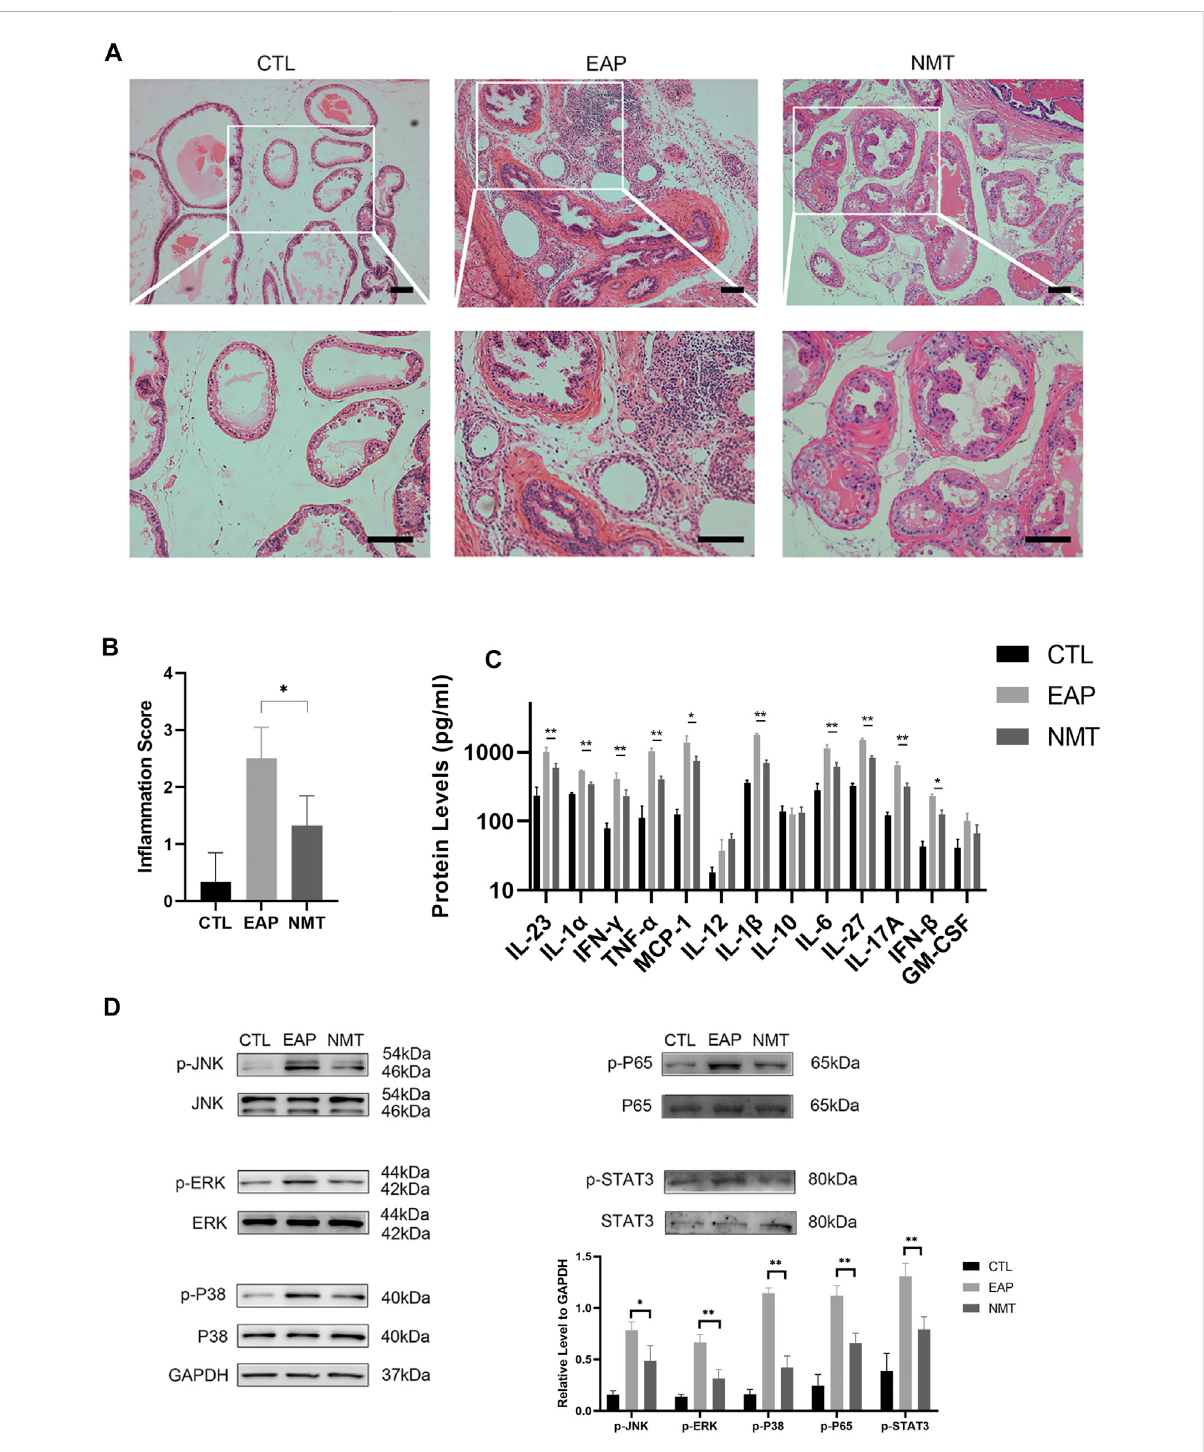
FIGURE 3 Decreased prostatic in fl ammation and in fl ammatory pain-related pathway activation in mice. (A) Sections of prostate tissues were stained with HE. Scale bar = 50 μ m; CTL = control; EAP = experimental autoimmune prostatitis mice; NMT: Ningmitai-treated mice. (B) In fl ammatory scores of the CTL, EAP, and NMT groups. n = 6. (C) Thirteen in fl ammatory-related factors in the CTL, EAP, and NMT groups. n = 6. (D) Western blotting analyzing of p-JNK, JNK, p-ERK, ERK, p-P38, P38, p-P65, P65, p-STAT3, STAT3, and GAPDH expressions as well as a statistical analysis of the results in the CTL, EAP, and NMT groups. n = 6. (*: p < 0.05; **: p <